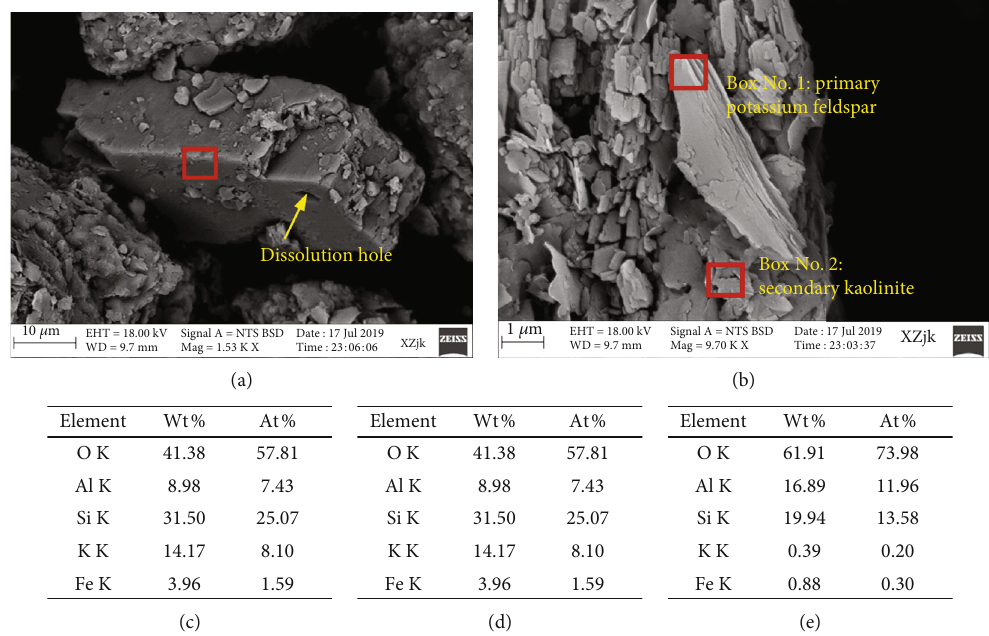
Figure 8: Dissolution/corrosion of fracture-surface primary minerals in sandy mudrock and secondary minerals formed on the surface of the primary minerals as observed through SEM. (a) Corroded potassium feldspar crystals (dissolution hole on the crystal surface). (b) Secondary kaolinite on the surface of primary potassium feldspar. (c) EDS analysis in the box of (a). (d) EDS analysis in the No. 1 box of (b). (e) EDS analysis in the No. 2 box of